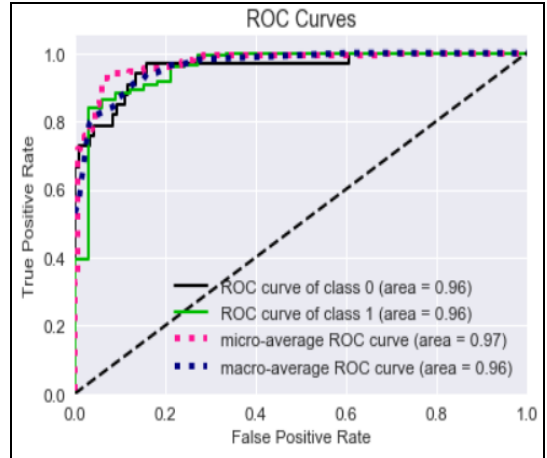
Figure 3. ROC curve of XGBoost using RFE on all feature subsets .